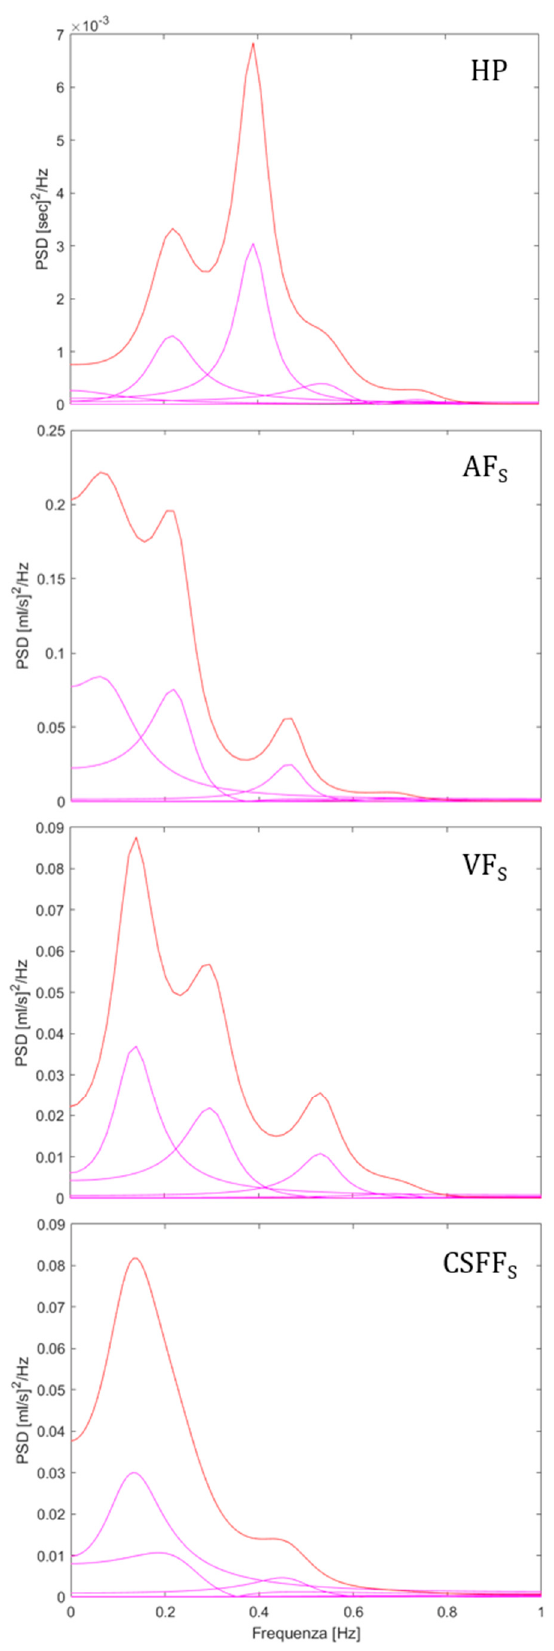
Figure 2. Example of AR PSD decomposition. From top to bottom: HP , AF S , VF S , and CSFF S . The represented spectra were computed from the MRI data of the same subject represented in Figure 1.